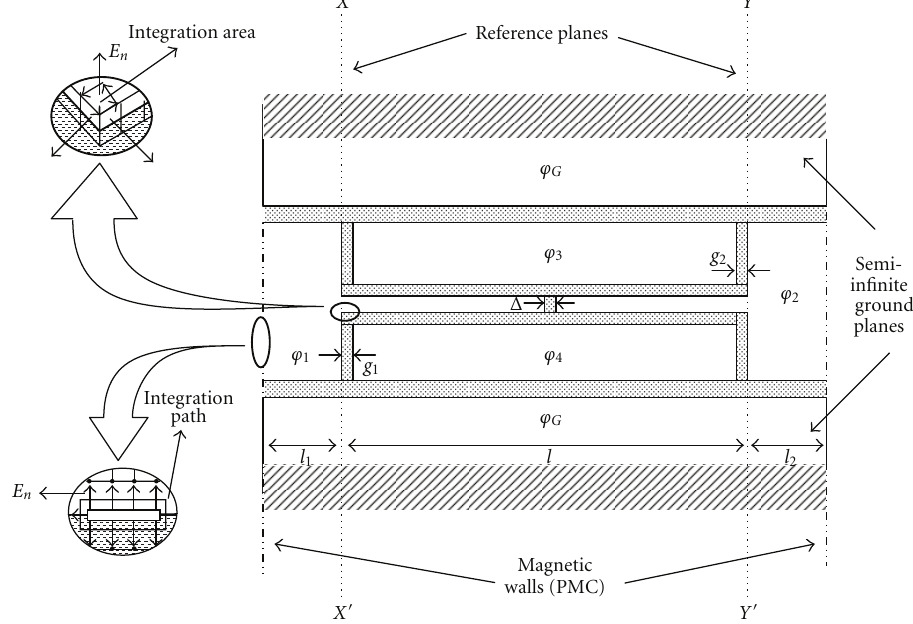
Figure 8: Setup for E -Field computation, l 1 = l 2 = 0 . 45 mm, g 1 = g 2 = 0 . 1mm, and l = 7 . 24 mm.